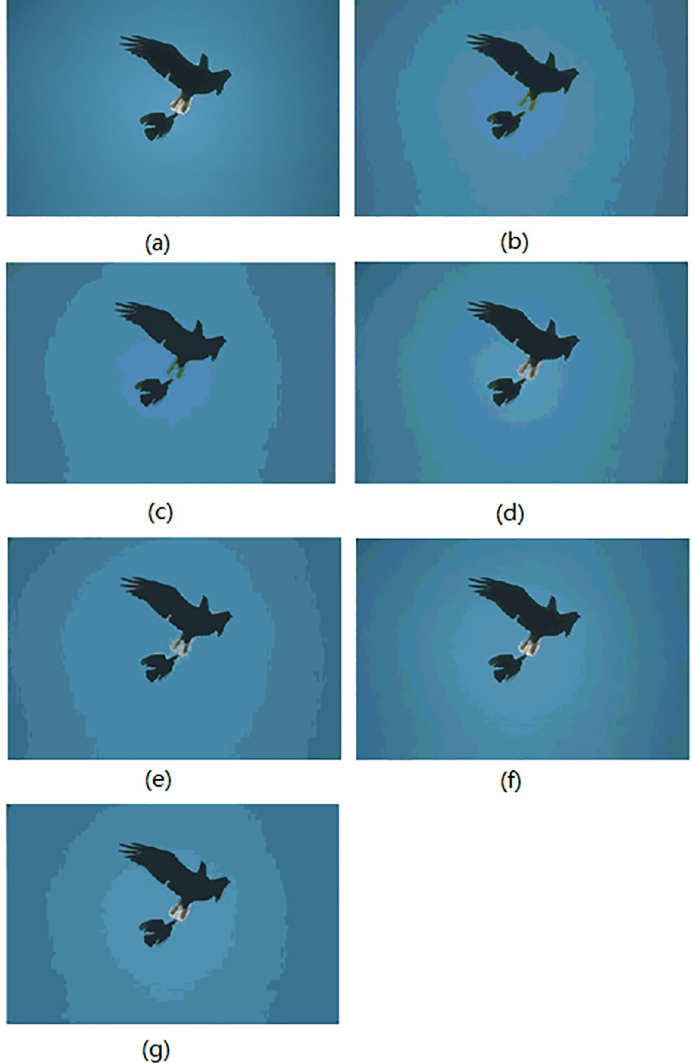
Fig 4. The image Birds : (a) original image, (b, c) initial segmented result and result after region merging based on the histon, (d, e) initial segmented result and result after region merging based on the roughness index, (f, g) initial segmented result and result after region merging based on AHHT